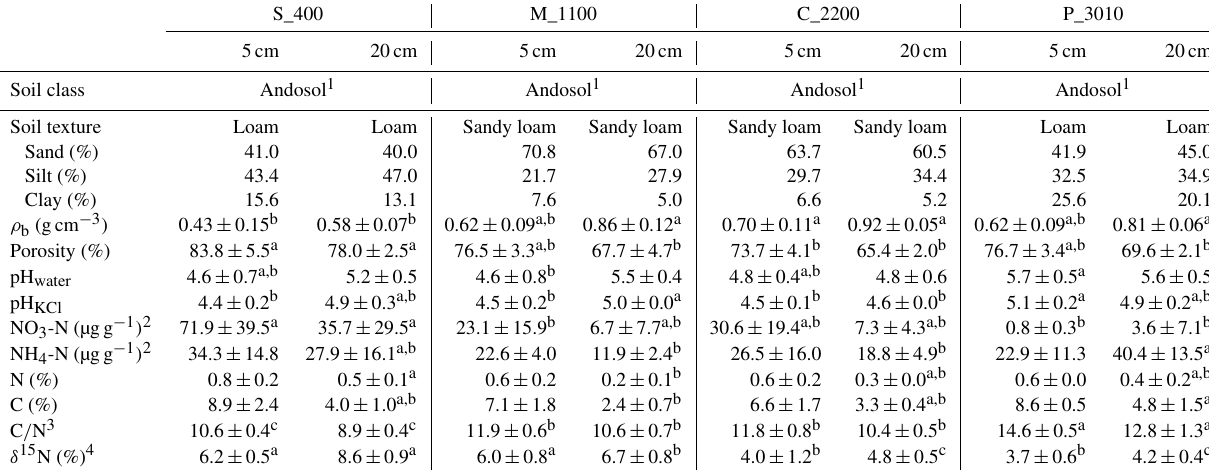
Table 2. Physicochemical soil properties of the study areas Río Silanche (400ma.s.l.; S_400), Milpe (1100ma.s.l.; M_1100), El Cedral (2200ma.s.l.; C_2200), and Peribuela (3010ma.s.l.; P_3010) at 5 and 20cm depth, including mean values plus or minus the standard deviations (SDs) of bulk density ( ρ b ), porosity, pH in water (pH water ) and KCl suspension (pH KCl ), nitrate (NO − concentrations, bulk nitrogen (N) and carbon (C) content, carbon-to-nitrogen ratio (C / N), and δ 15 N signatures from samples of soil taken in August. Similar lowercase letters in superscript and next to some values within one row and per depth (5 and 20cm) indicate no significant difference at P < 0 . 05 between sites (S_400, M_1100, C_2200, and